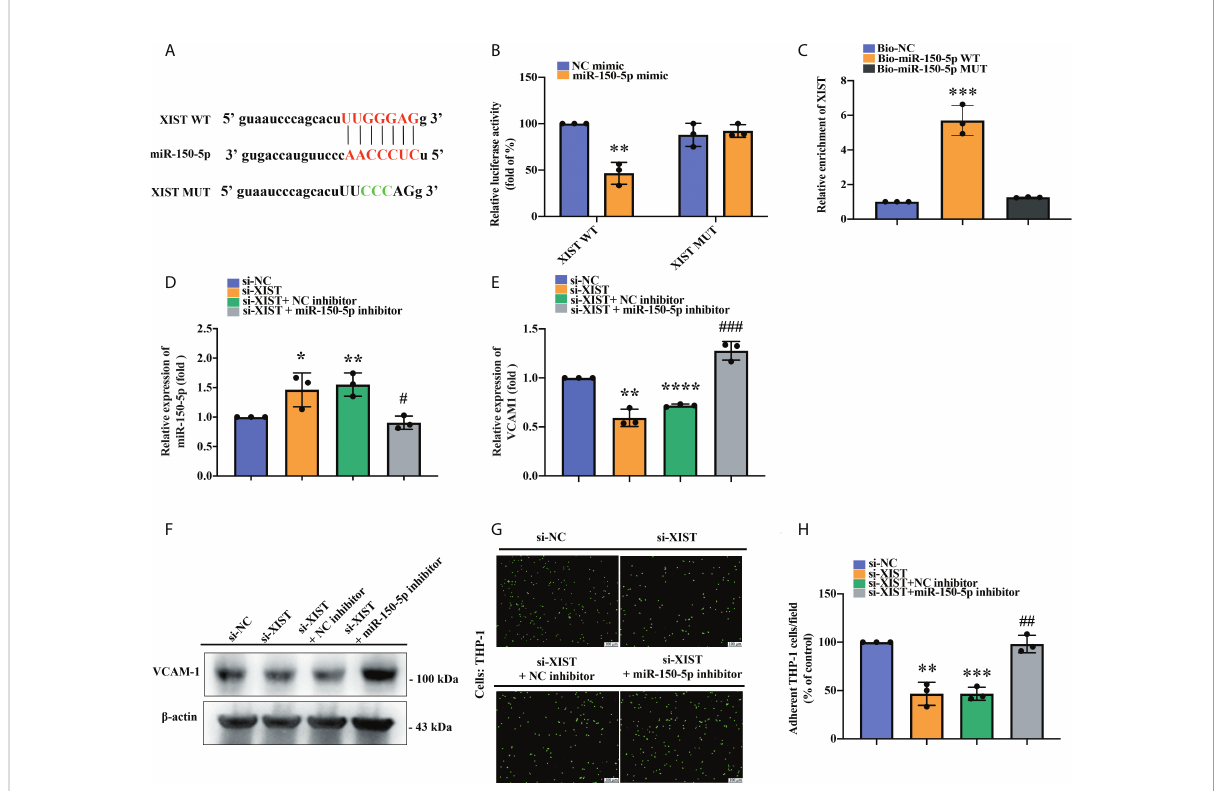
FIGURE 5 The effect of XIST knockdown on monocyte adherence was blocked by miR-150-5p downregulation. (A) The schematic diagram illustrates the sequences of miRNA-150-5p interactions with XIST in the ENCORI database. (B) A luciferase reporter assay was performed to con fi rm the interaction between miR-150-5p and XIST. The XIST WT plasmid and XIST MUT plasmid were each co-transfected with miRNA-150-5p mimic into OASFs for 24 h. Luciferase activities were determined by the luminometer in three independent experiments. (C) The RNA pull-down assay revealed direct binding of miR-150-5p with XIST. The biotinylated probes (Biotin-NC, Biotin-miR-150-5p WT, Biotin-miR-150-5p MUT) were transfected into HEK-293 cells for 48 h. The cells were lysed and incubated with M280 magnetic streptavidin beads for 4 – 6 (h) The biotin- coupled RNAs were isolated using TRIzol reagent and measured by RT-qPCR assay in three independent experiments. (D) miR-150-5p expression was examined by RT-qPCR after OASFs were co-transfected with XIST siRNA and the miR-150-5p inhibitor for 24 h in three independent experiments. (E, F) After transfecting OASFs with XIST siRNA and the miR-150-5p inhibitor, the cells were subjected to RT-qPCR for mRNA expression and to Western blot for protein expression in three independent experiments. (G, H) OASFs were transfected with XIST siRNA, miR-150-5p inhibitor, or their respective controls for 24 h. BCECF-AM labeled THP-1 cells were co-cultured with OASFs for 1 h, then adherent THP-1 cells were determined by fl uorescence microscopy in three independent experiments. * p < 0.05 and ** p < 0.01, *** p < 0.001, **** p < 0.0001 compared with control siRNA or control mimic; # p < 0.05, ## p < 0.01, ### p < 0.001 compared with XIST